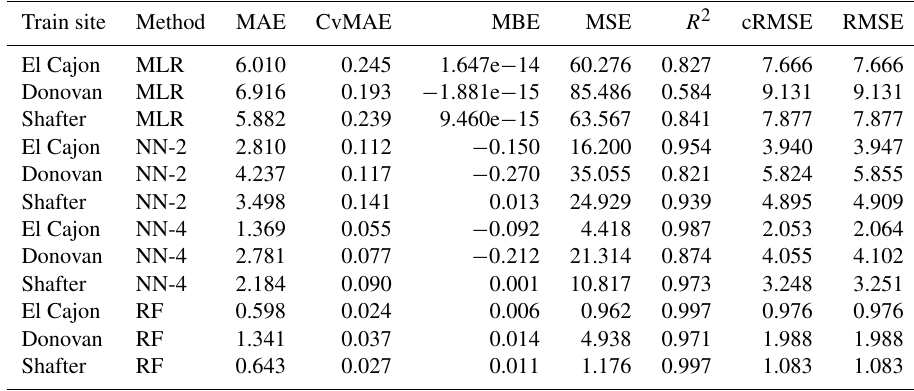
Table C3. Level 0 train results for O 3 (train and test on the same data set).